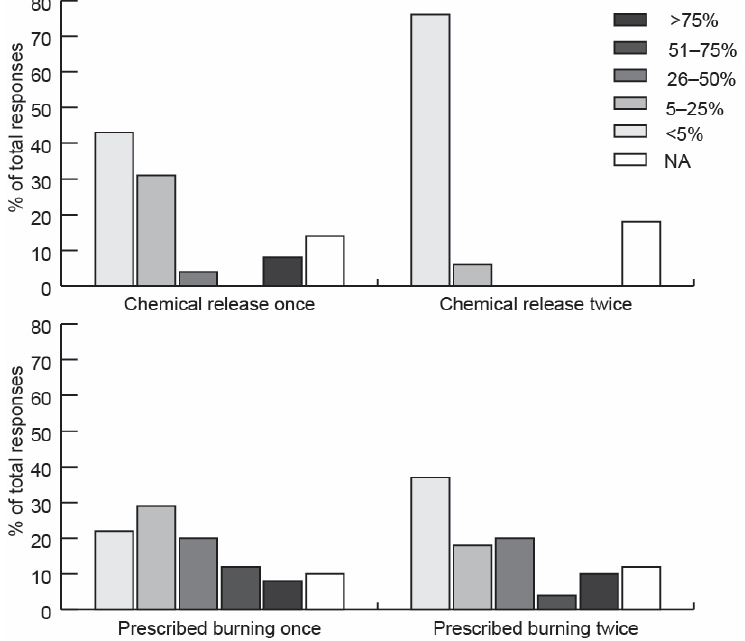
Figure 4. The survey respondents’ reported mid-rotation forest management practices conducted in pine–hardwood mixed stands in Georgia.